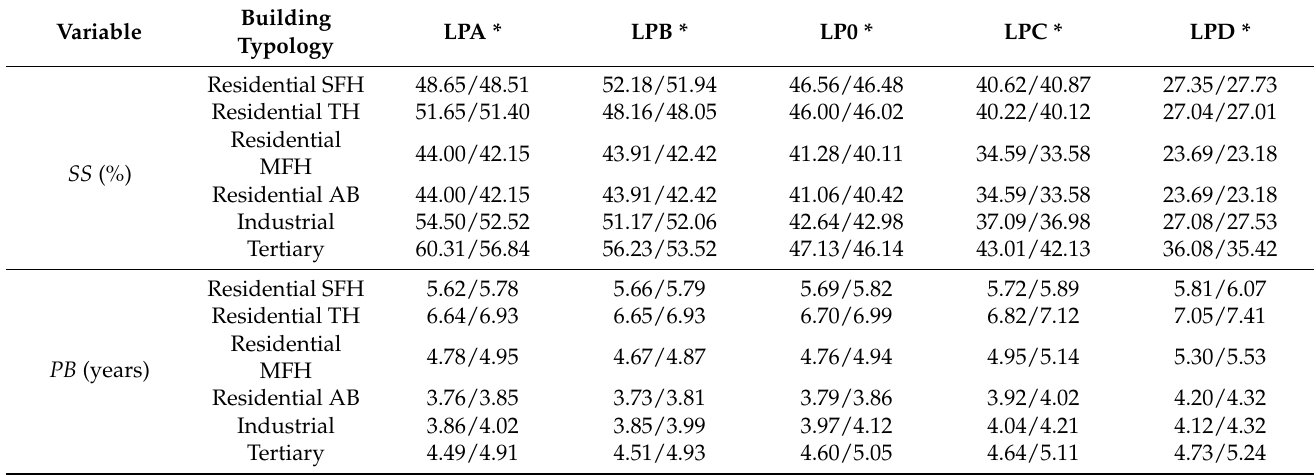
Table 7. Main statistical values of LPA, LPB, LPC and LPD by building typologies and billing scheme for the base load profile